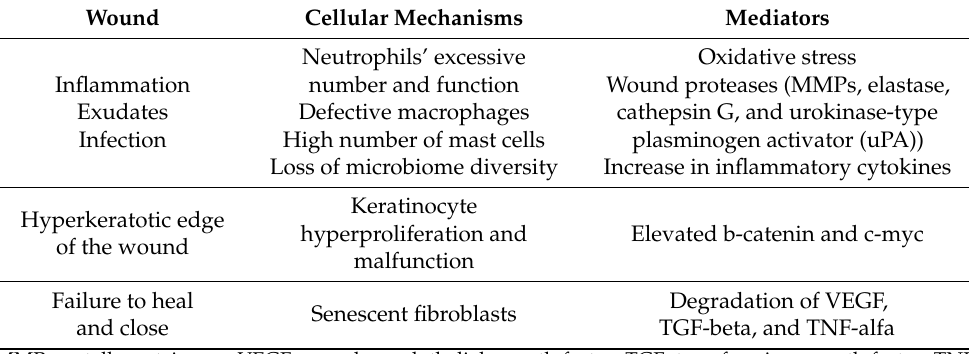
Table 2. Mechanisms found in failure to heal wound (FHW). Wound Cellular Mechanisms